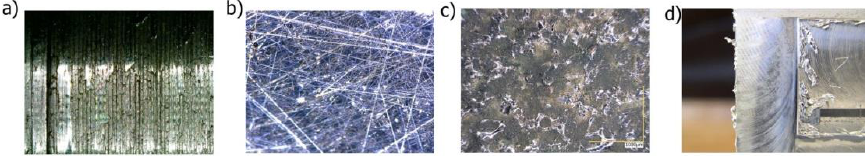
Figure 1. Examples of surface defects: ( a ) grooves, ( b ) scratches, ( c ) craters, ( d ) burrs.